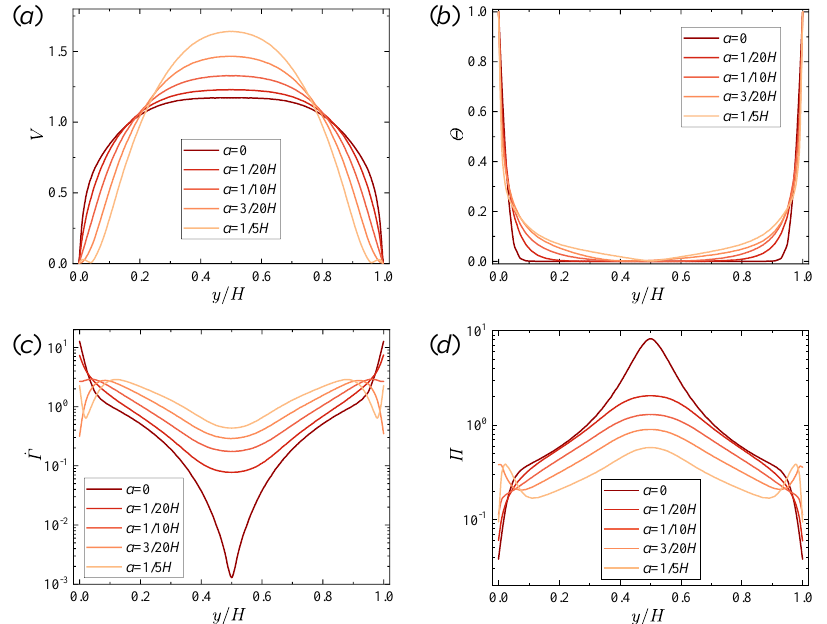
Figure 11. Profiles of the dimensionless ( a ) velocity, ( b ) temperature, ( c ) shear rate and ( d ) viscosity in the transverse direction at the outlet of test section for different wave amplitudes. The length of the wave is 2𝐻 , and 𝑅𝑒 gen,CY is 130.